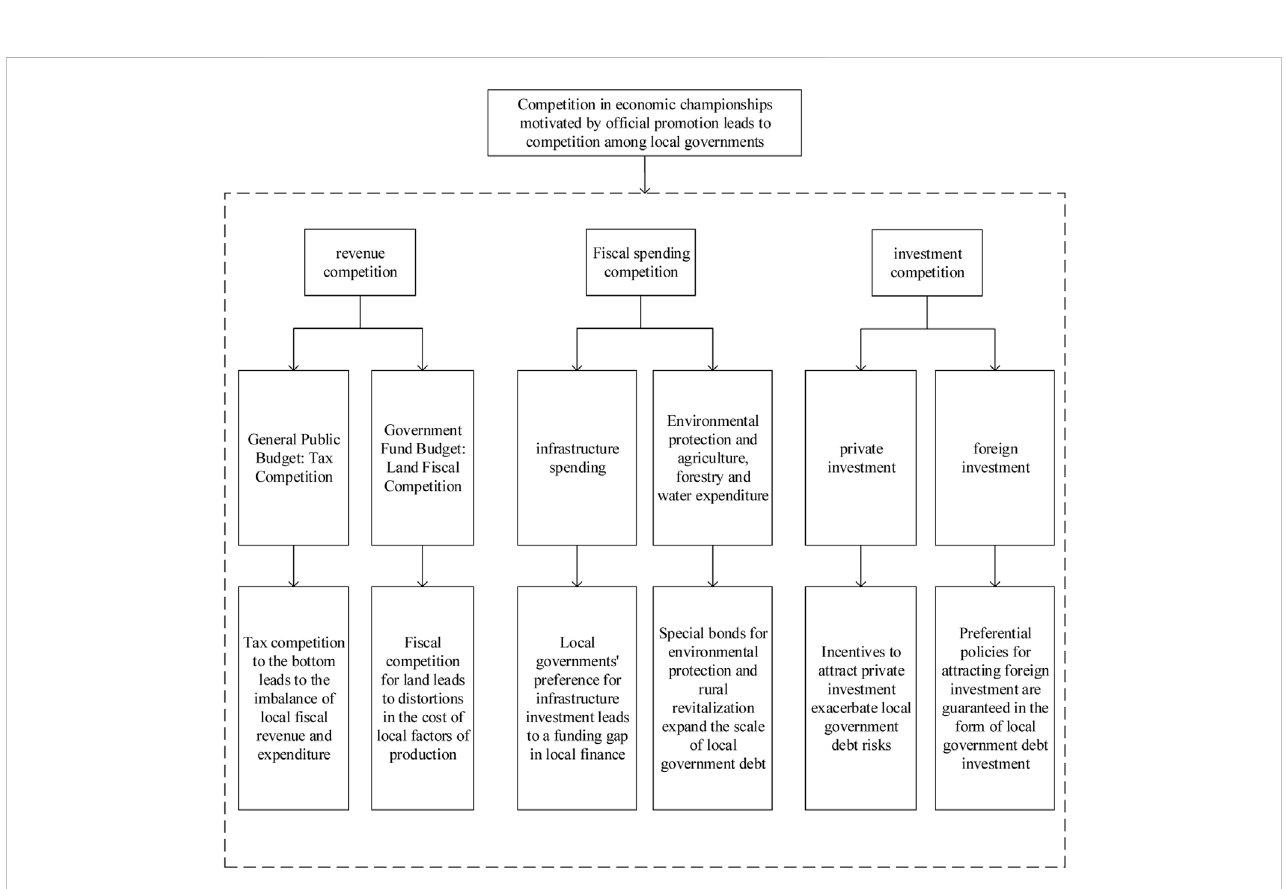
FIGURE 2 The mechanism of the role of inter-governmental competition on local government debt